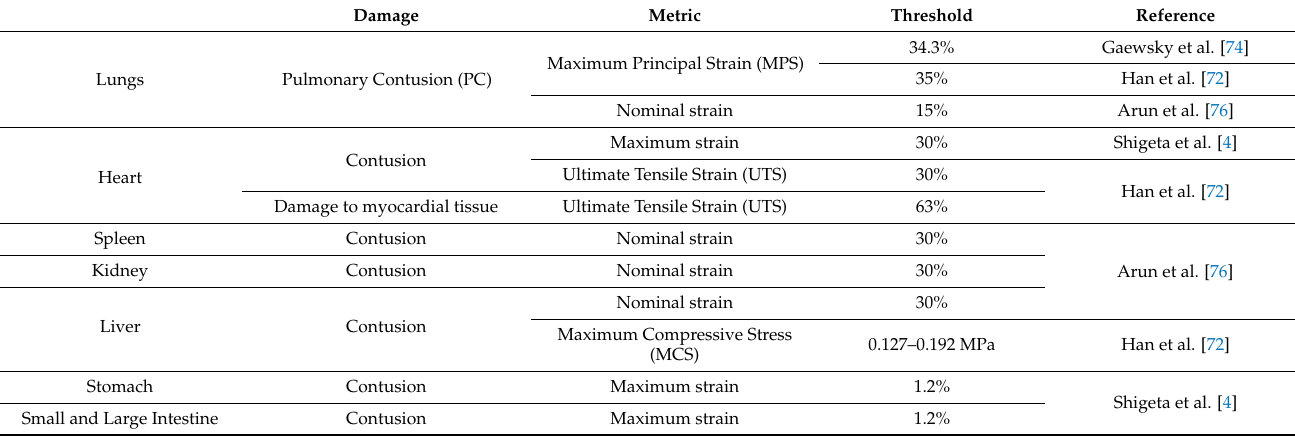
Table 4. Summary of the main IC proposed for the internal